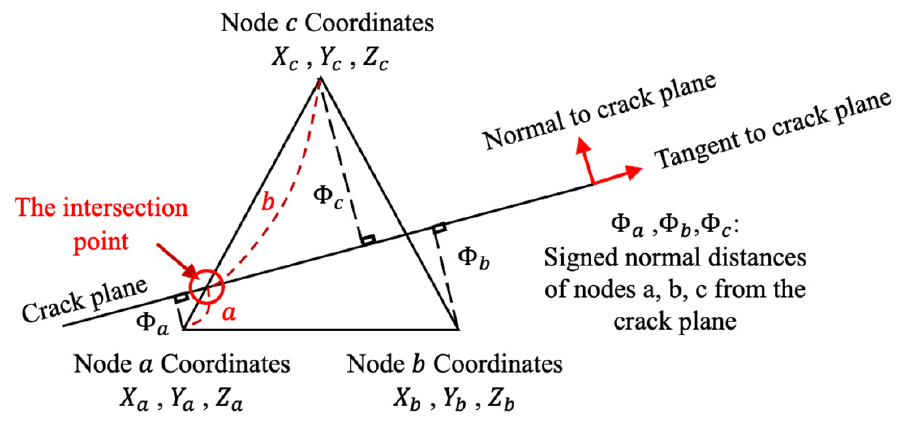
Figure 4. A schematic for calculating the junction spots’ coordinates.